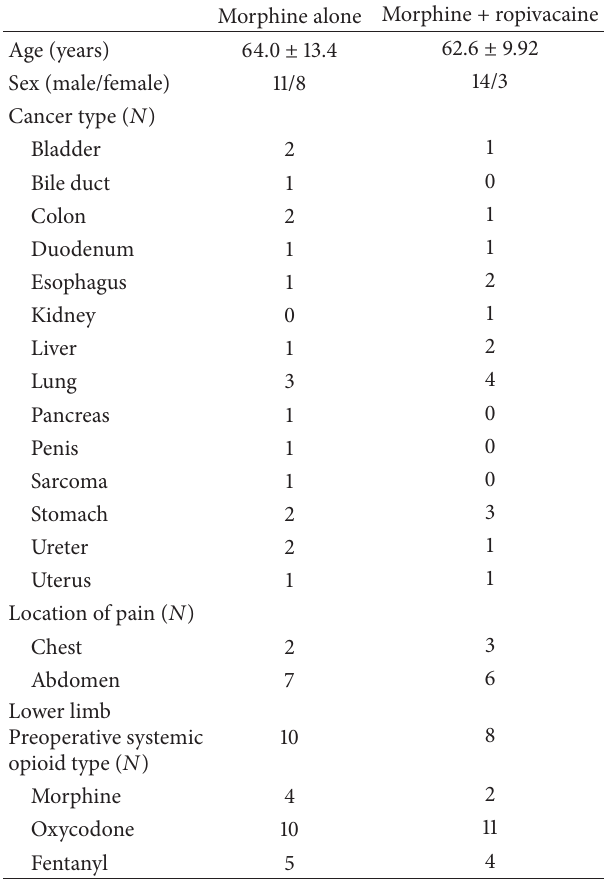
Table 1: Demographics and clinical data ∗